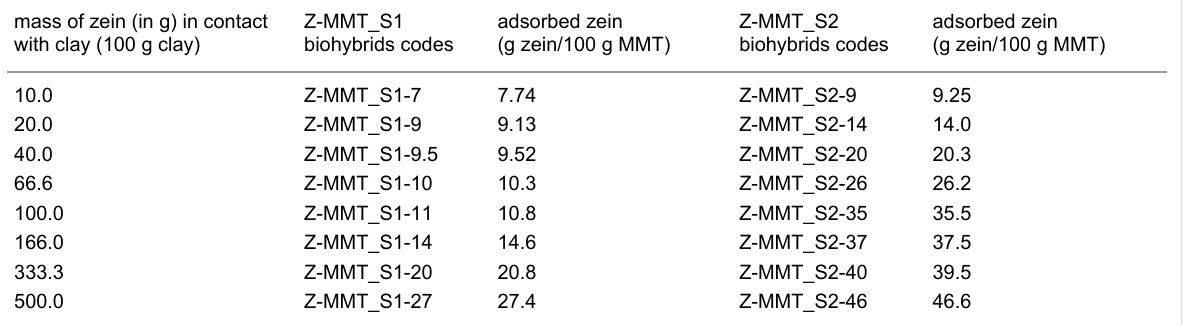
Table 1: Biohybrids of the Z-MMT_S1 and Z-MMT_S2 series, prepared by adsorption of zein from 80% (v/v) ethanol/water solution and from zein segregated phases in absolute ethanol, respectively. The protein content was determined by CHNS chemical analysis. mass of zein (in g) in contact with clay (100 g clay)